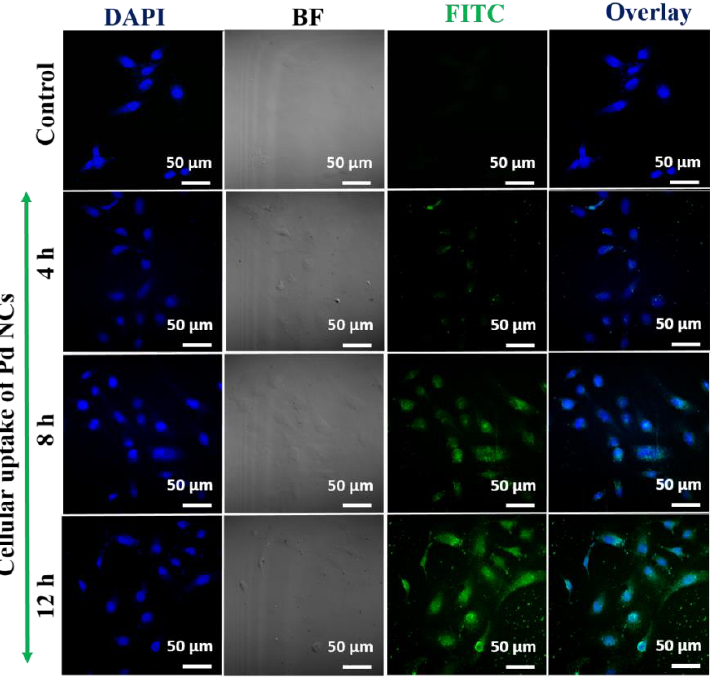
Figure 5. Time dependent cellular uptake of Pd NCs internalized HeLa cells. Green fluorescence originates from the Pd NCs and blue fluorescence corresponds to DAPI which is nucleus staining agent. The concentration of Pd NCs is 100 µg·mL −1 .